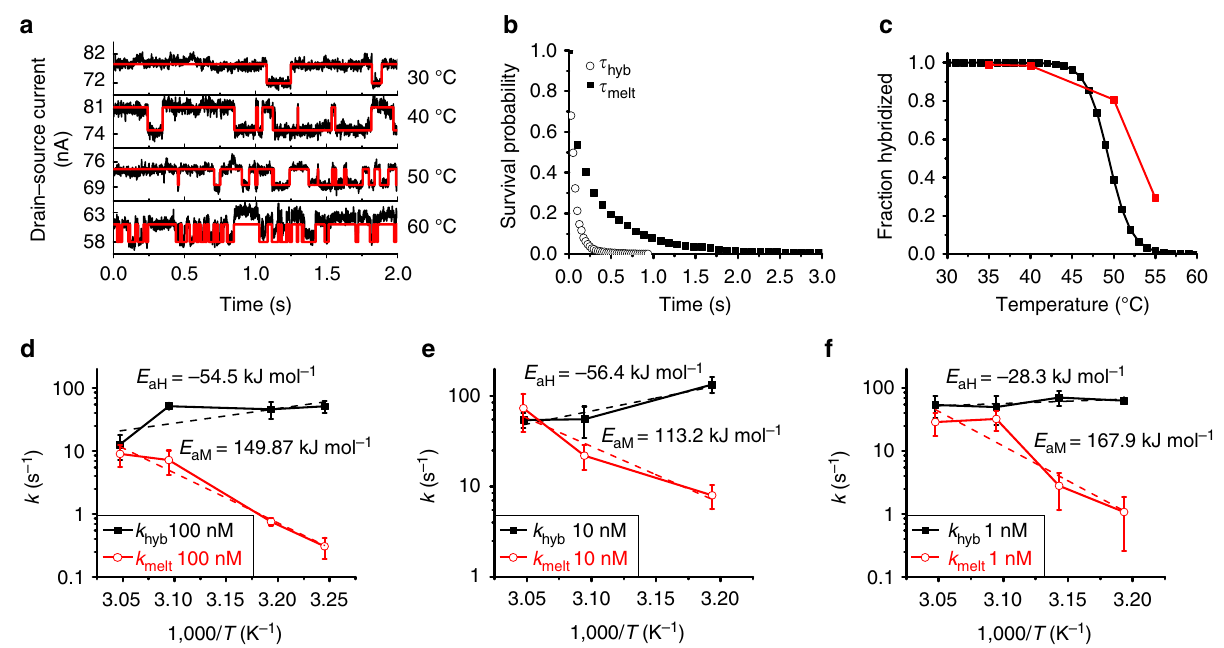
Figure 2 | Temperature-dependent DNA hybridization and corresponding data analysis. ( a ) Time traces of 300-s length are recorded for complementary DNA target at a concentration of 100nM. Overlaid raw real-time data (black) and idealized fits (red) for a temperature series from 30 to 60 (cid:2) C. The rate of bi-stable activity increases with temperature. ( b ) A representative survival probability curve for the 50 (cid:2) C trace from a , with an event count of 763. The fit quality is characterized by R 2 ¼ 0.999 and R 2 ¼ 0.998 for t low - high and t high - low , respectively. ( c ) Comparison of nearest-neighbour calculated and single-molecule measured melting curves for a 100nM complementary target showing the same temperature dependence as a ‘traditional’ melting curve exhibiting a lower hybridized fraction with increasing temperature and a T m of 52.99 (cid:2) C compared with a calculated T m ¼ 49.66 (cid:2) C. ( d – f ) Arrhenius plots for 100, 10 and 1nM target concentrations, showing the temperature dependence of the melting and the hybridization rates. Error bars are calculated from five different 60-s intervals at each